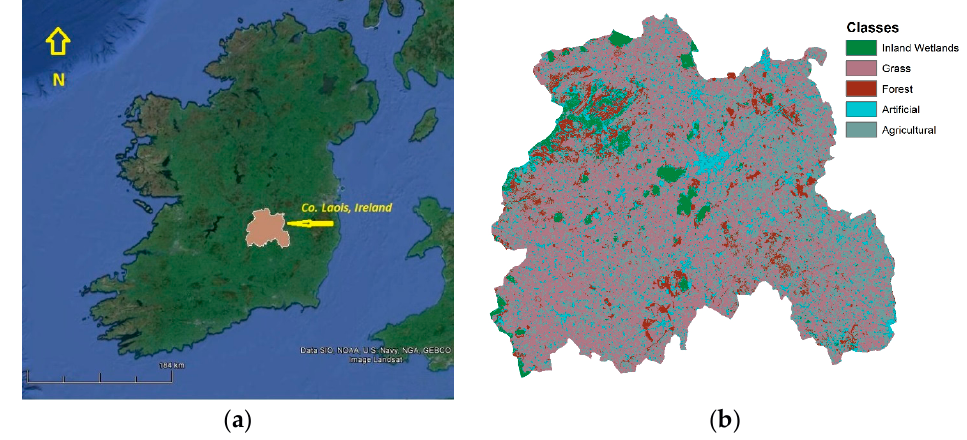
Figure 1. Study Area: ( a ) Laois County, Ireland, Google Earth; and ( b ) Laois land ‐ use classification map. Radiometric and geometric correction were applied to the initial TM image deploying the related header file given by USGS [32–35]. Spectral radiance and reflectance image files for each TM band were derived using Digital Numbers (DNs) and Gain and Bias levels for each channel as described at Landsat 7 Science Data Users Handbook [36]. The geometrically corrected images were projected to the Irish map conversion system using the Irish 1965 datum, based on a Transverse Mercator projection and the Airy Modified 1849 Spheroid. The same system is used throughout this study. Each image was finally cropped to the area of interest using the appropriate county shape file. The results of